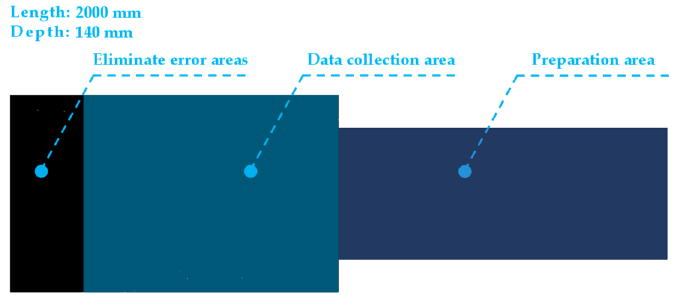
Figure 1. Schematic diagram of the soil bin DEM virtual simulation model.